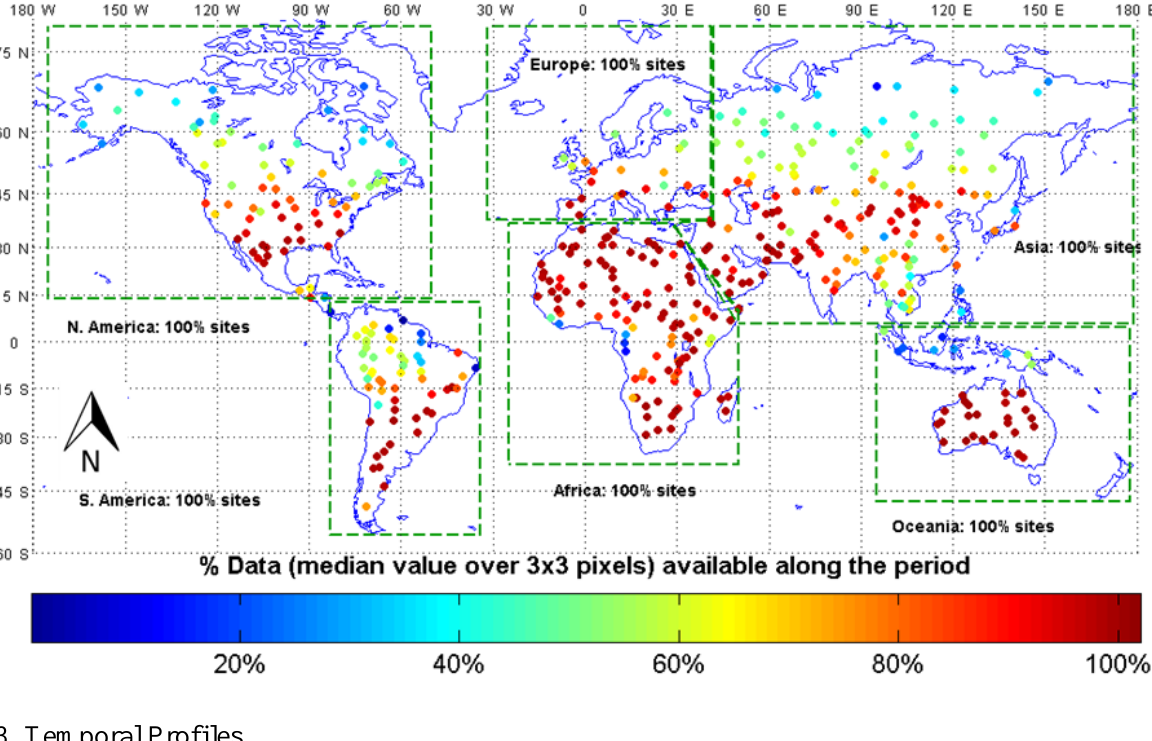
Figure 4. Fraction of valid data for the GEOV1/VGT FAPAR product. Colored dots correspond to the 445 BELMANIP2.1 sites, with color corresponding to the fraction (%) of valid data over 3 × 3 km 2 , during the period defined in Table 2, and for the original temporal sampling. Six continental domains are identified by the dashed green lines (North America, South America, Europe, Africa, Asia and